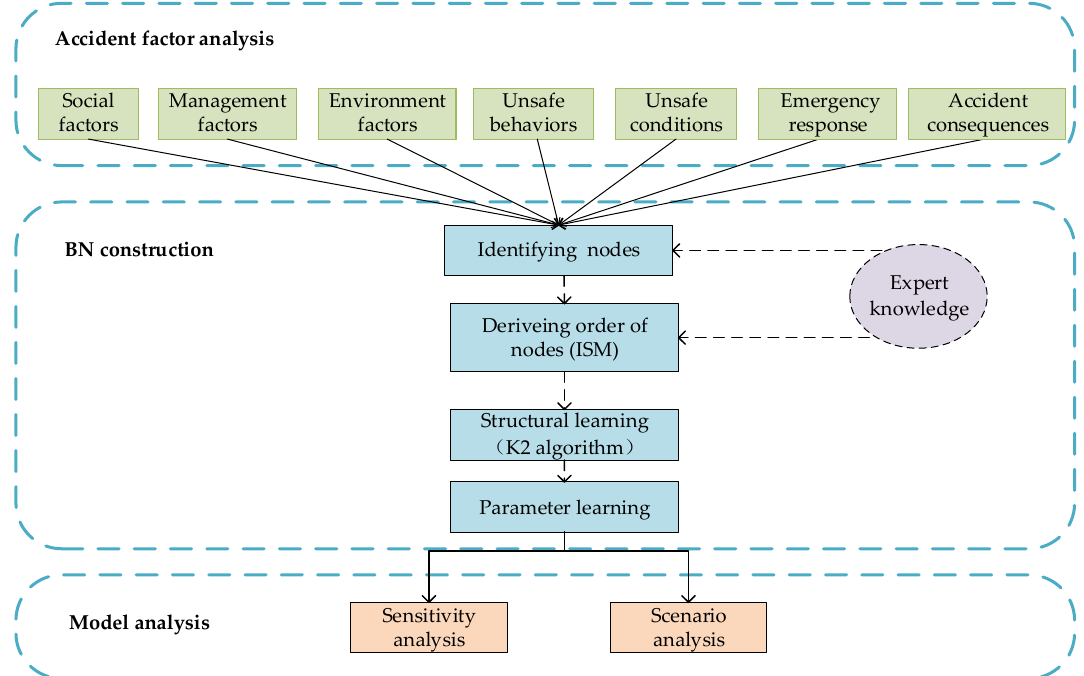
Figure 1. The overall structure of the method proposed in this paper.